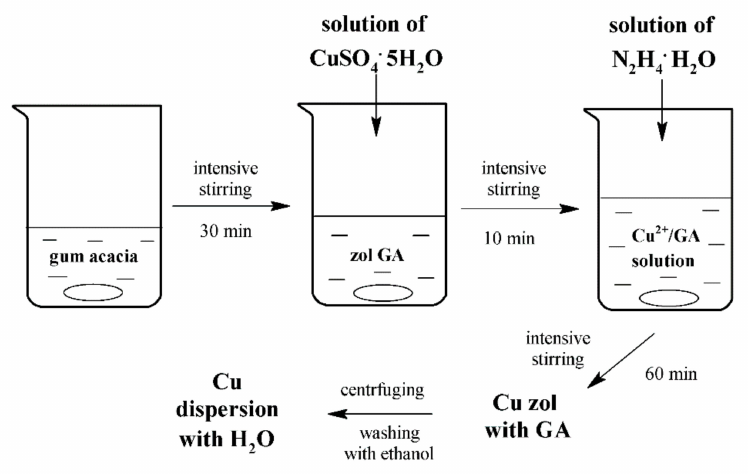
Figure 1. Scheme of synthesis of Cu